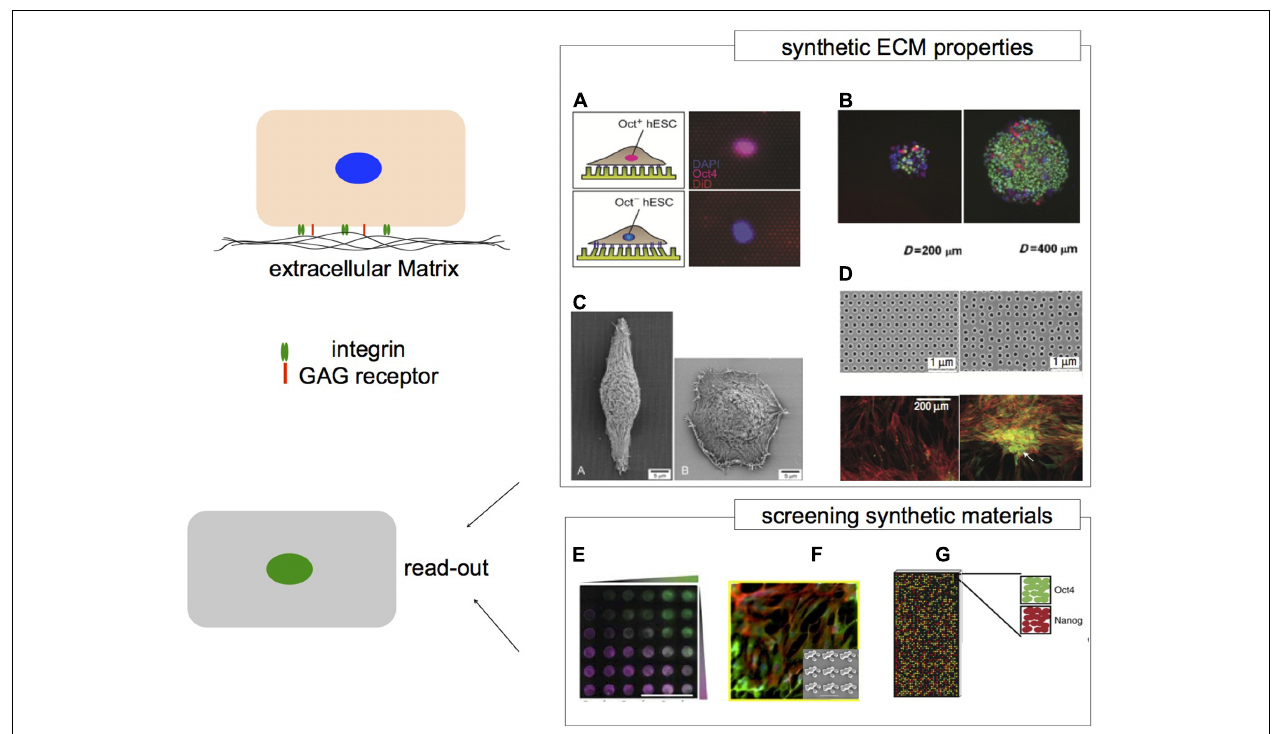
protein concentration gradients and PEG stiffness. FITC- and rhodamine labeled BSA gradients are represented in green and magenta, respectively. (F) The Topochip platform can be used to vary surface topography of the same material chemistry. (G) Spotted polymer arrays of varied substrate mechanical properties for long term culturing of hES cells. (A) Image adapted from Sun etal. (2012b). (B) Peerani etal. (2007), image adapted with permission from John Wiley and Sons, Copyright 2007. (C) Teixeira etal. (2003), image reproduced with permission from Journal of Cell Science , Copyright 2003. (D) Dalby etal. (2007), image reprinted with permission from Macmillan Publishers